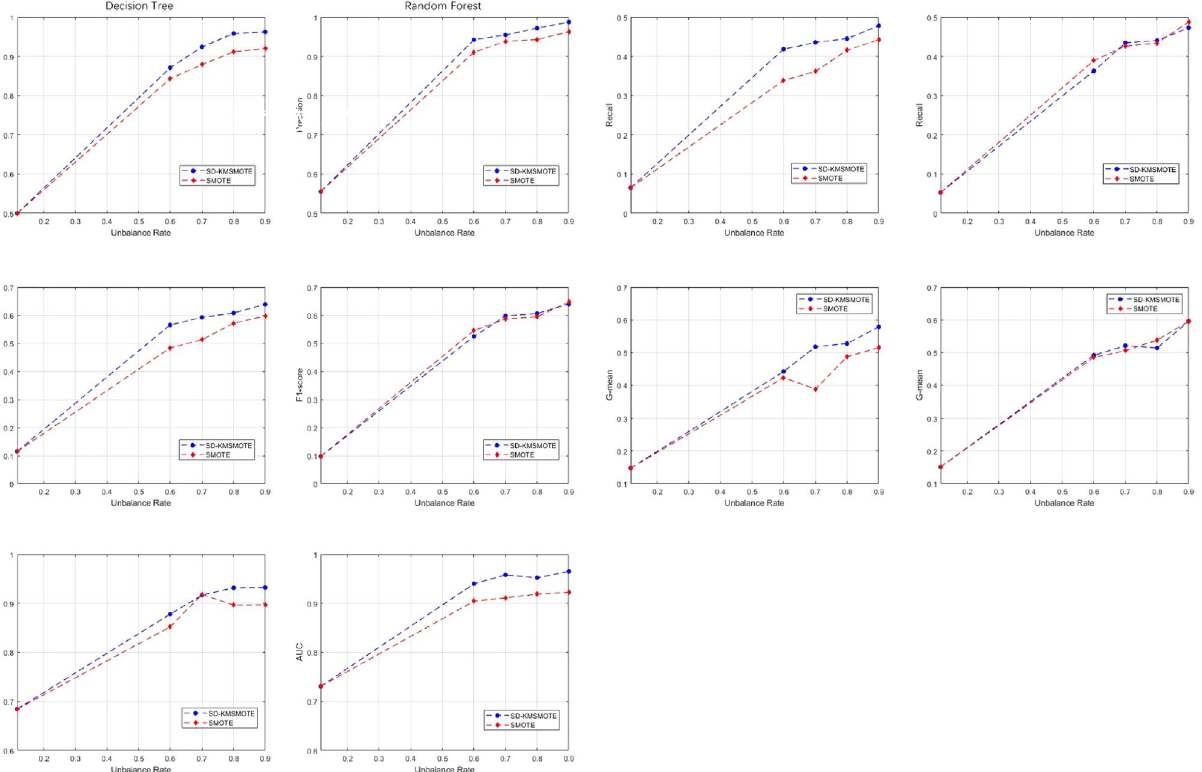
Figure 5. Comparison of evaluation indexes of E.coli under different equilibrium